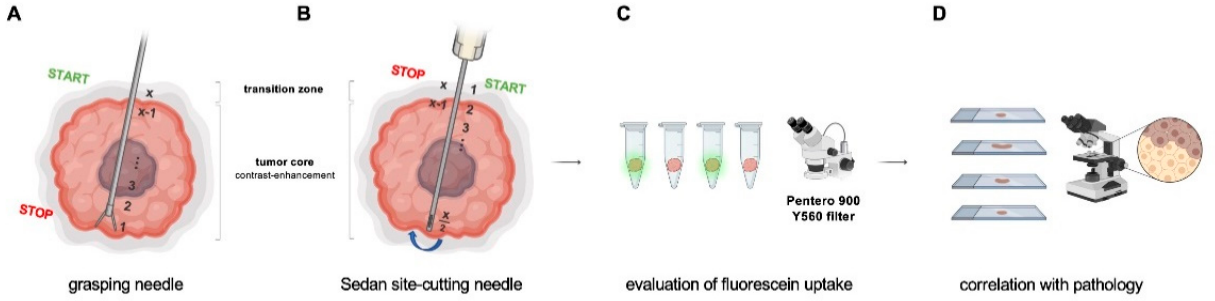
Figure 1. Biopsy technique and workflow. ( A ) Using a grasping needle of the Riechert–Mundinger system, the first biopsy was typically taken in the most distant part of the tumor, and for each consecutive specimen, the next trajectory was moved proximally through the tumor core until the transition zone. ( B ) When using the Sedan side-cutting needle, the initial biopsy was taken in the transition zone and then further advanced to the tumor core until the tumor margin. The needle was then turned 180 ◦ and samples were taken in a step-wise retrograde fashion. ( C ) Each tumor sample was evaluated under the Pentero 900 Y560 filter for fluorescein uptake. ( D ) Fluorescein uptake patterns were then correlated with histopathological diagnosis ( x = number of total samples per patient).